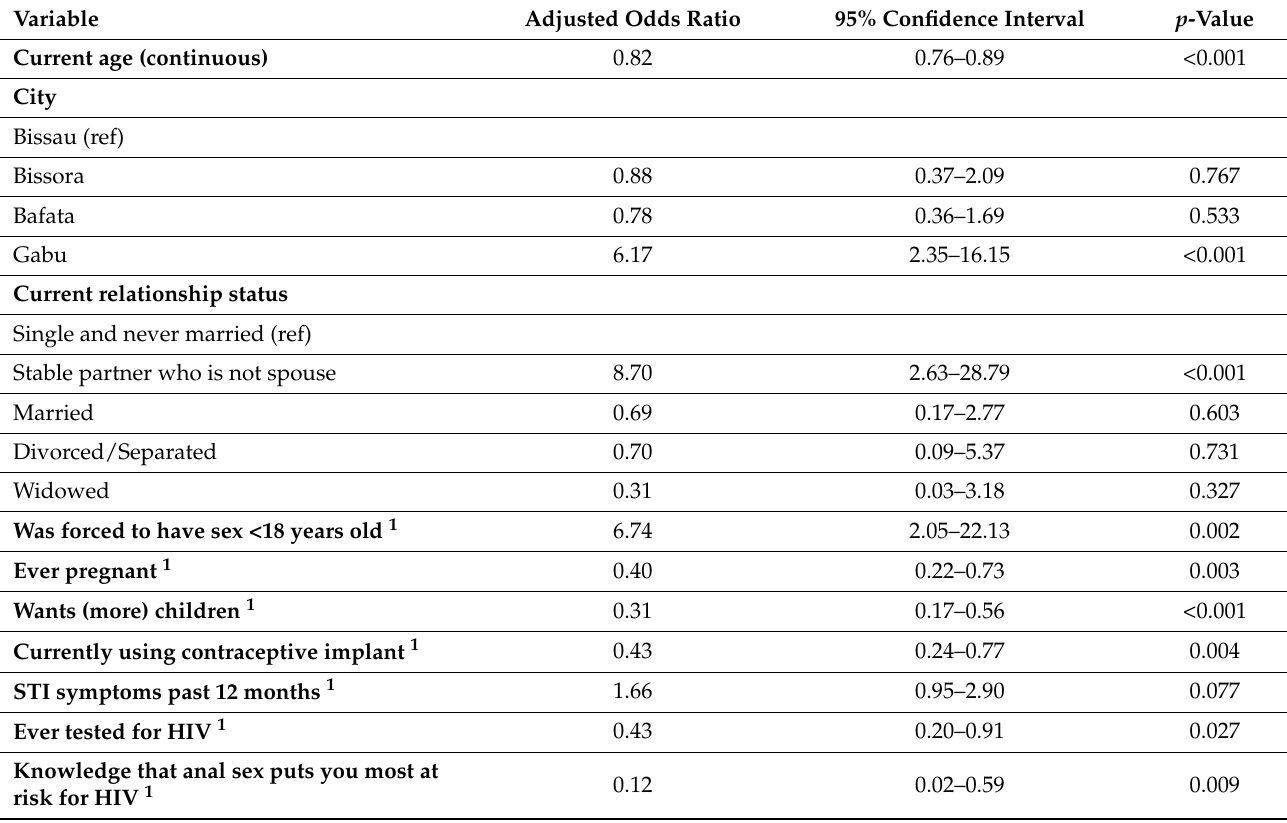
Table 3. Multivariable logistic regression analysis of correlates of underage initiation of selling sex among female sex worker study participants (n = 468) in Guinea-Bissau,